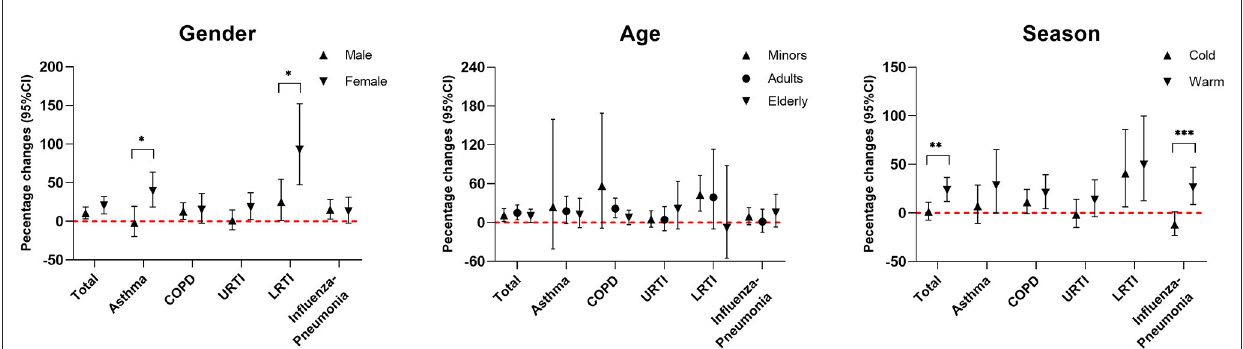
FIGURE4 Percent changes (95% CI) in daily hospitalizations for respiratory diseases for each 1 mg/m 3 increase in carbon monoxide over different subgroups. Stratified analyses were performed at lag0–2 of ambient CO concentration for total and specific respiratory diseases. Models were adjusted for long-term and seasonal trends, temperature, relative humidity, public holiday, and DOW (day of the week). * P < 0.05; ** P < 0.01; *** P < 0.001.